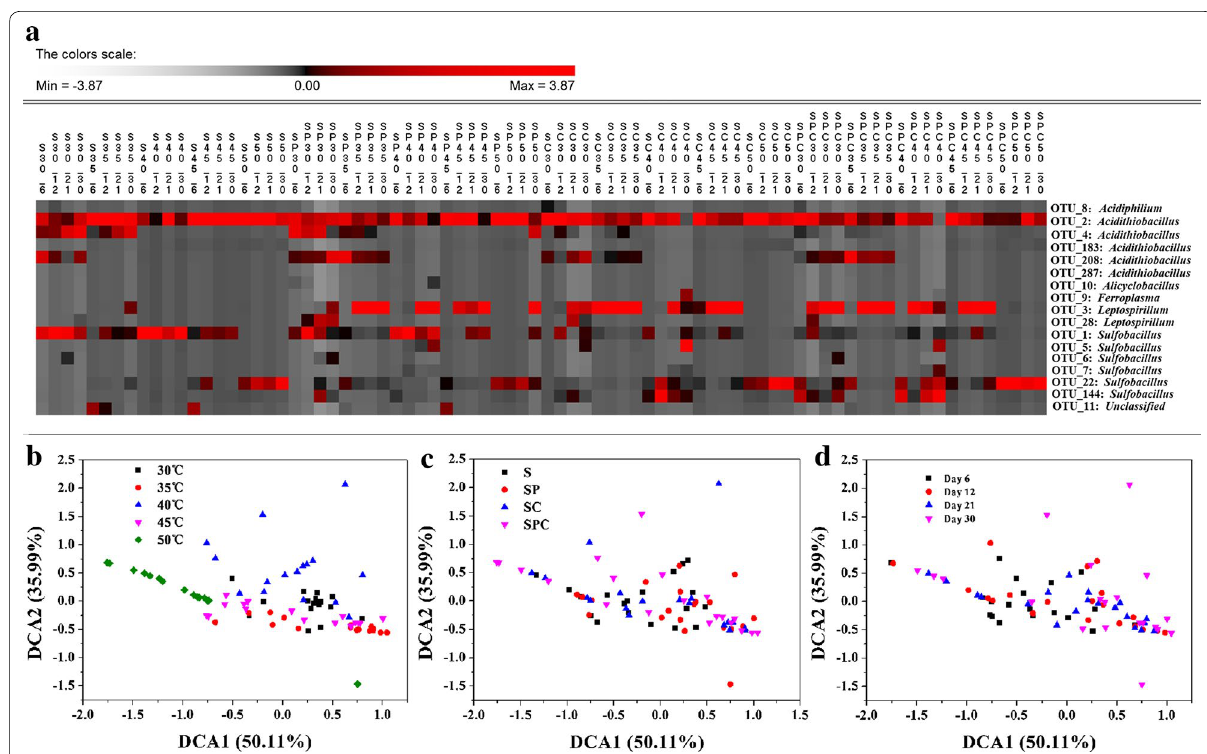
Fig. 4 Polts of microbial community composition at OTU level ( a ) and microbial community structure under different temperature ( b ), mineral composition ( c ) and stages ( d ) using detrended correspondence analysis